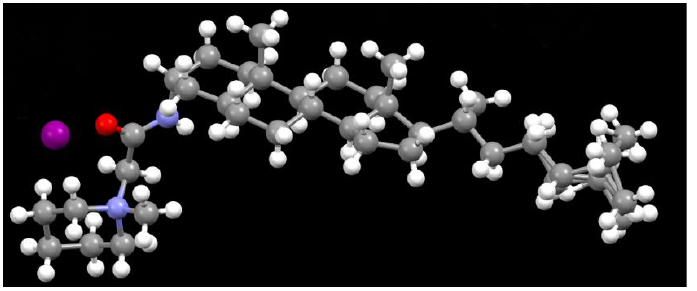
Figure 2. X-ray crystal structure of IMC-48 synthesized by the new route.